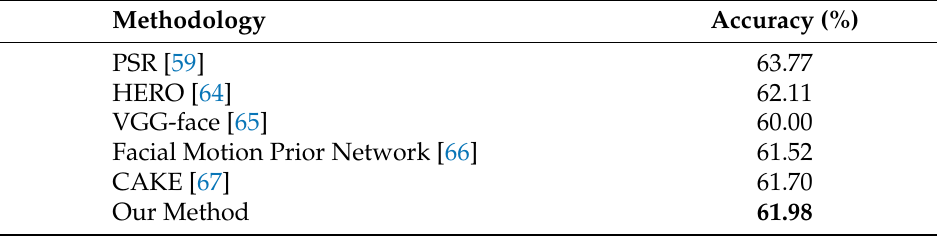
Table 7. Performance comparison on AffectNet dataset.